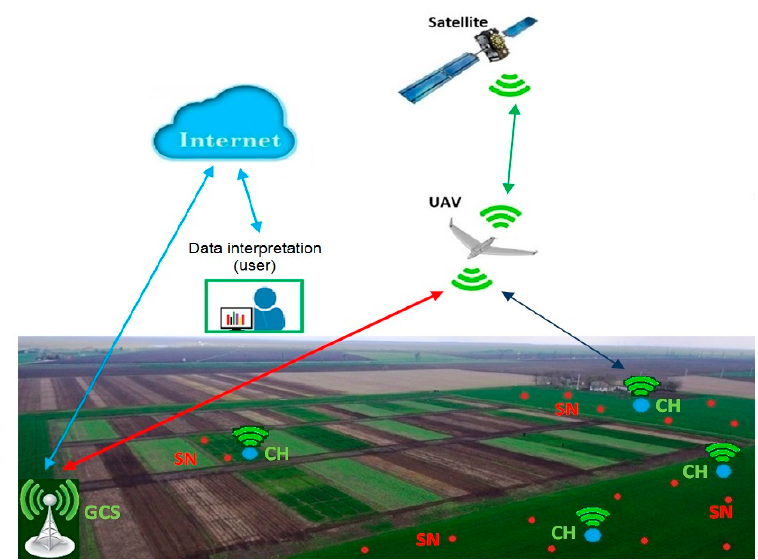
Figure 1. The concept of the integrated unmanned aerial vehicle (UAV)–wireless sensor network (WSN)–Internet of Things (IoT) system.